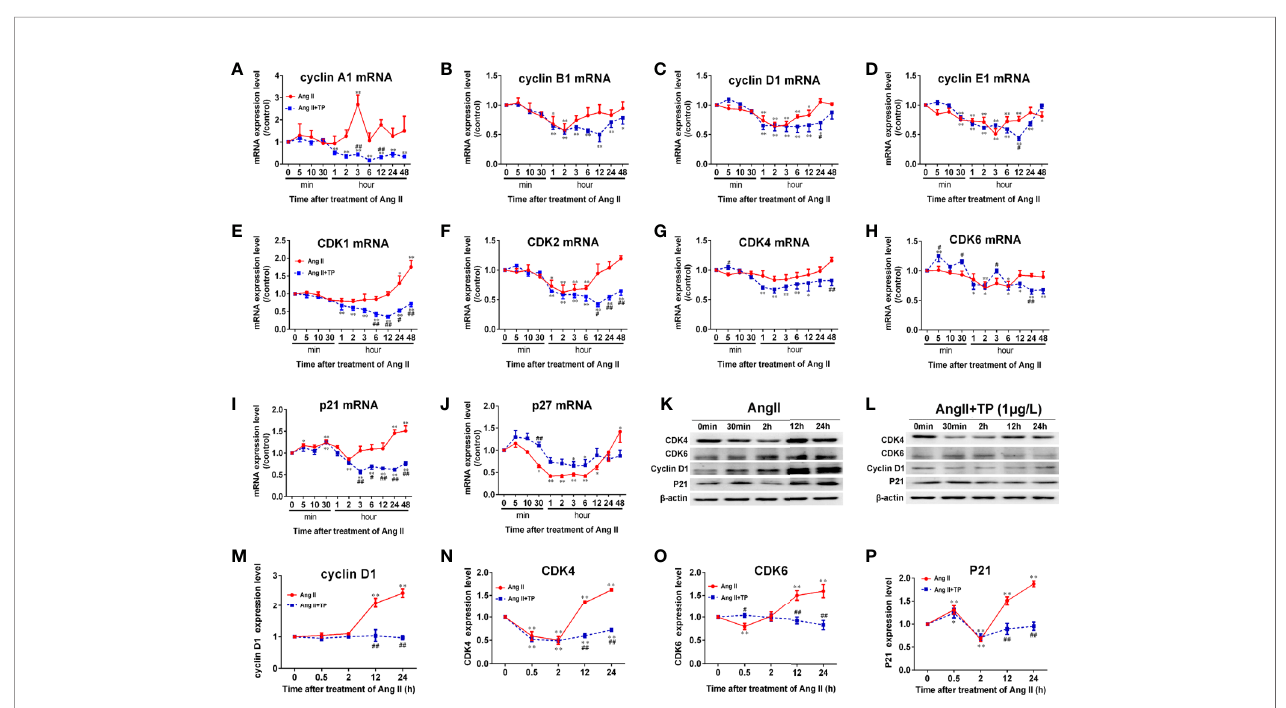
FIGURE 3 | Expression of cell cycle regulators at the mRNA and protein levels in NRVMs. (A – J) The mRNA expression levels of cyclin, CDK, and CDKI were measured with real-time PCR ( n = 6) and normalized to b -actin and the control group, respectively. (K, L) Cyclin D1, CDK4 and 6, and P21 protein levels as shown by Western blot analysis ( n = 4). (M – P) The intensity of each band was quanti fi ed by densitometry and normalized to the b -actin and control groups. Data are shown as the mean ± SEM, *P < 0.05, **P < 0.01 compared with the controls (0 min), # P < 0.05, ## P < 0.01 compared with the Ang II-treated group at same time point (one-way ANOVA).